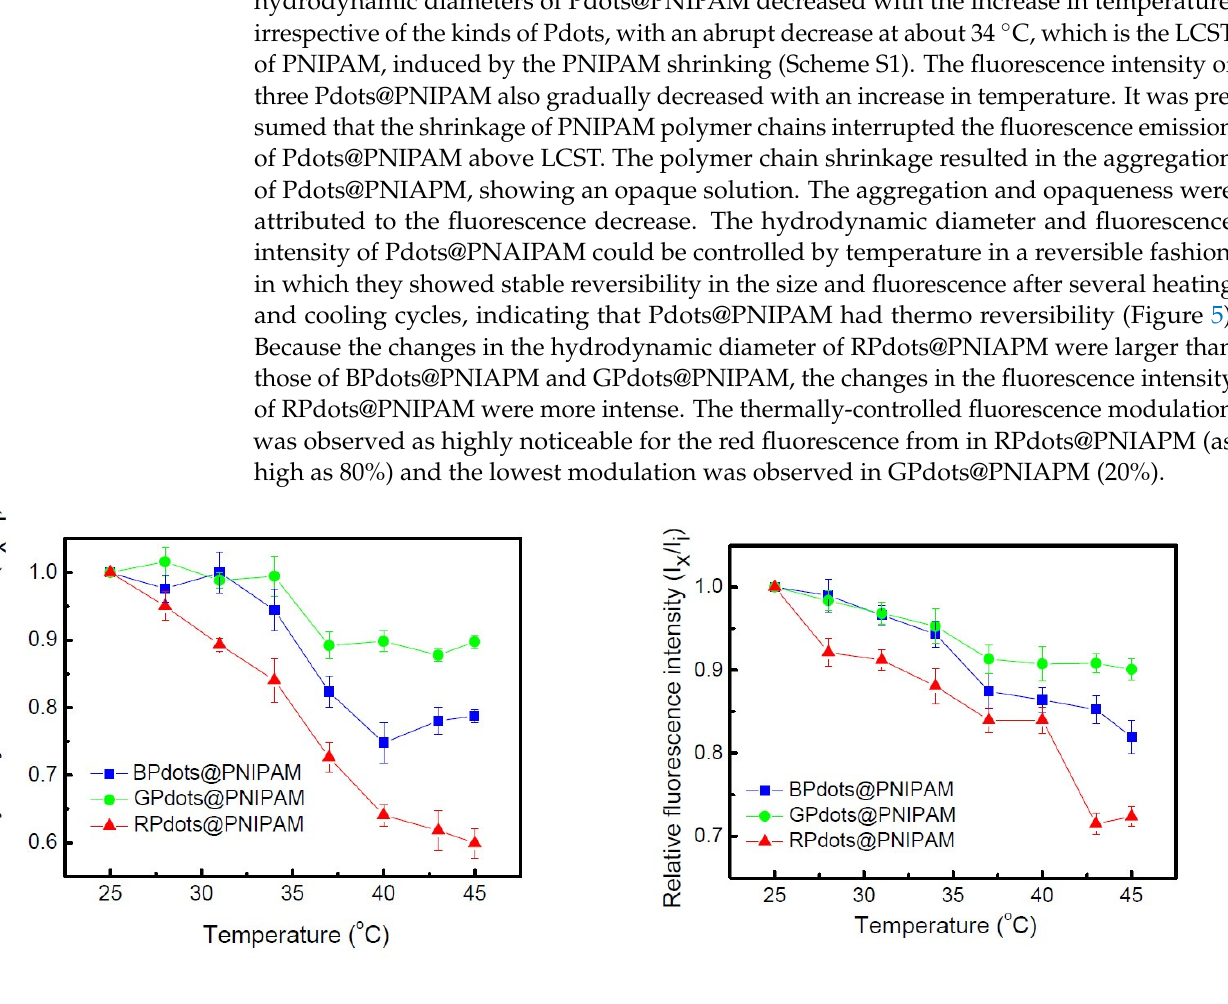
Figure 4. Changes in the ( a ) hydrodynamic diameters and ( b ) fluorescence intensities of Pdots@PNIPAM in aqueous solution upon increase in temperature. d i and d x correspond to hydrodynamic diameters at 25 ◦ C and at elevated temperature, respectively. I i and I x correspond to fluorescent intensities at 25 ◦ C and at elevated temperatures, respectively. Excitation wavelength 350 nm.